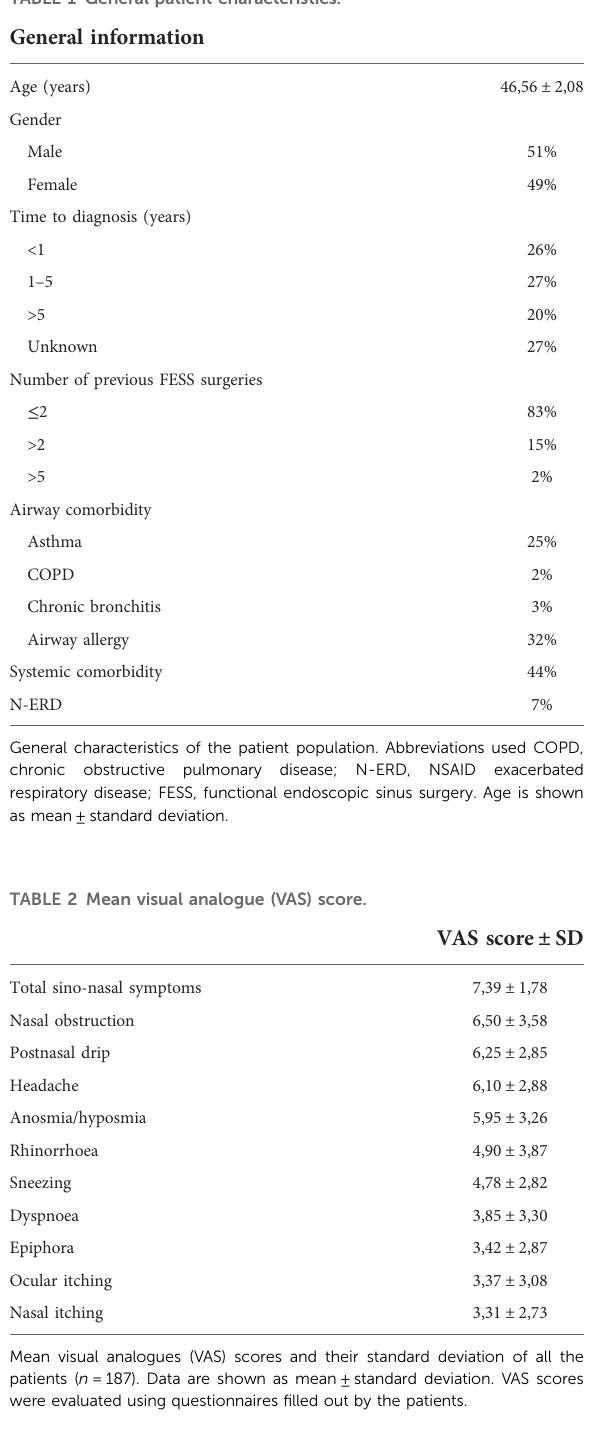
TABLE 1 General patient